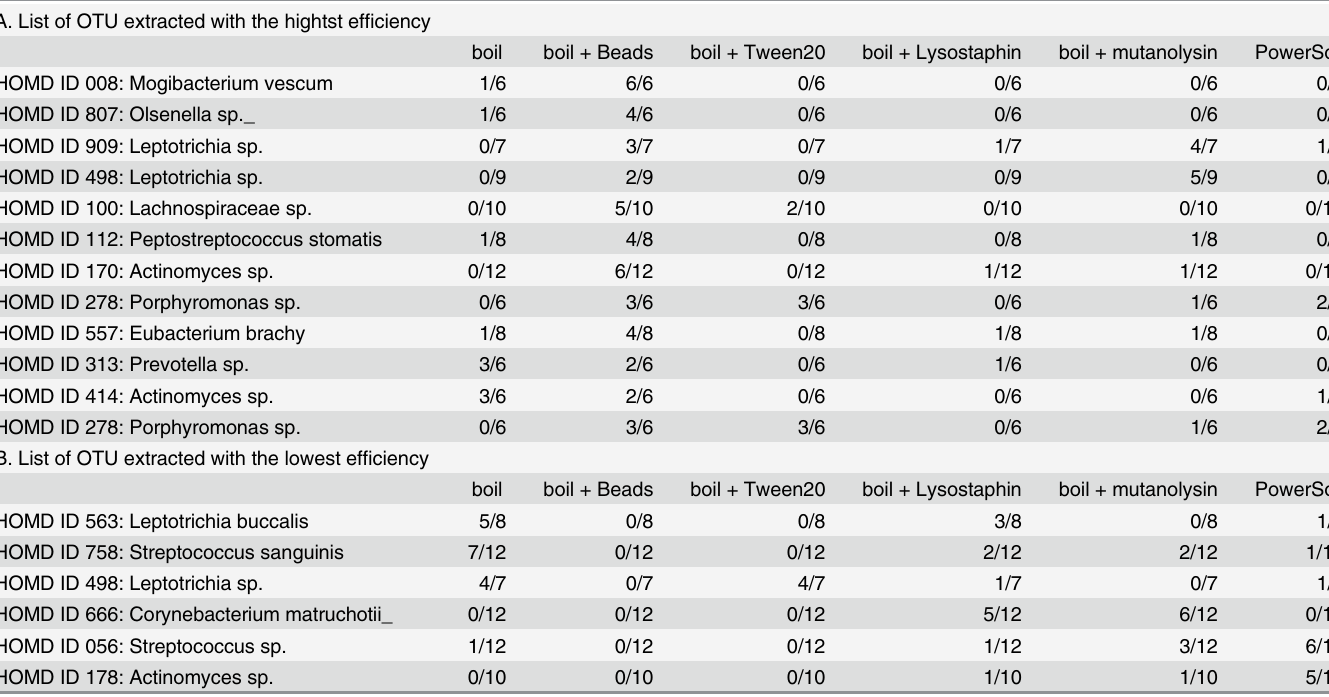
Table 3. Variation of DNA extraction efficiency using each